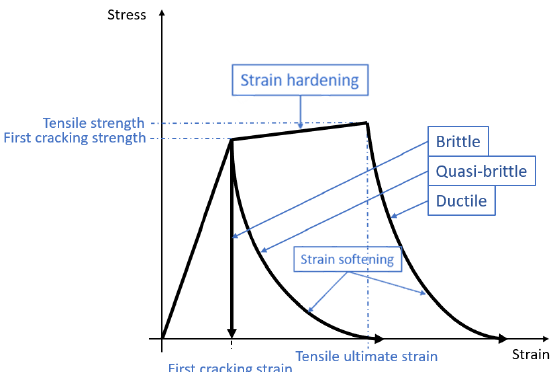
Figure 4. Cracking modeling—strain softening and strain hardening under uniaxial tensile loading.